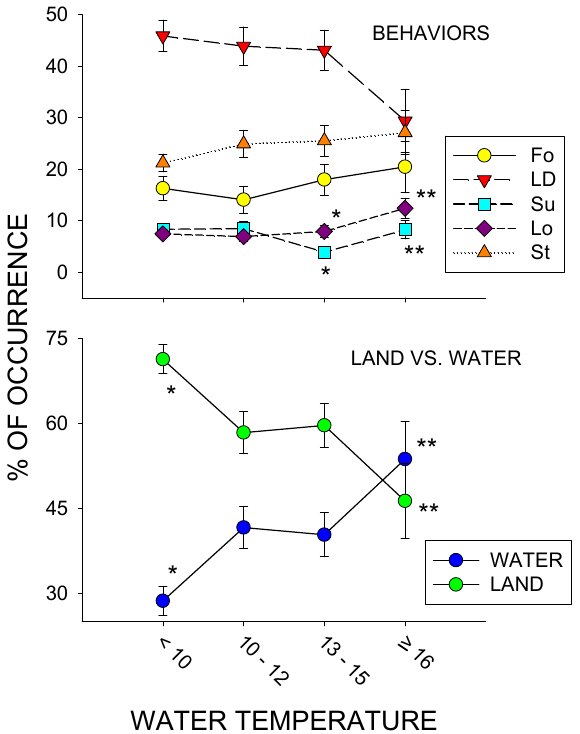
Figure 4. Percentage of activity (with standard error of the mean bars [SE]) for the 5 most frequently occurring responses (Lying Down (LD), Standing (St), Foraging (Fo), Locomotion (Lo) and Submerged (Su); top graph) and for water vs. land use (bottom graph) across four different water temperature conditions (<10, 10–12, 13–15, and ≥ 16 °C) for the entire study (January–July). Both graphs include standard error of the mean bars, with * and ** indicating significant differences within each category (e.g., * to ** = water use between <10 and ≥ 16 °C) across the different temperature conditions ( p < 0.05).